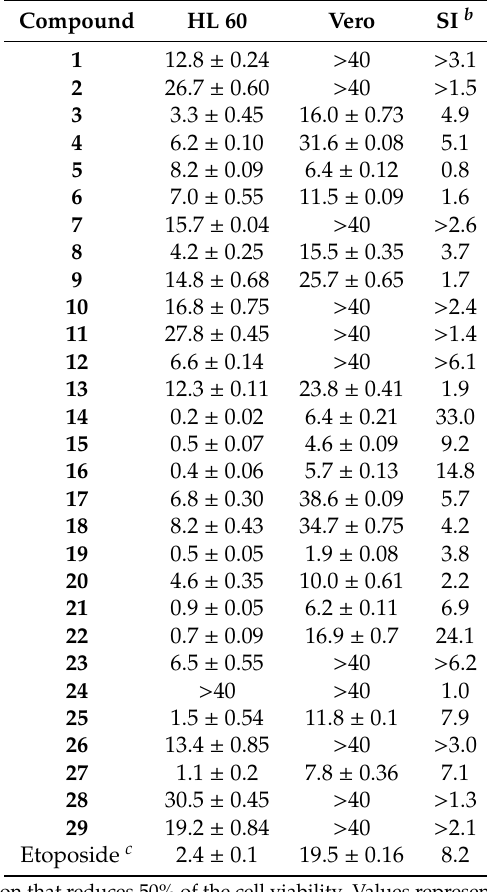
Table 3. Cytotoxic activity a (IC 50 , µ M) of withanolides 1 – 29 against leukemia HL-60 and non-tumoral Vero cell